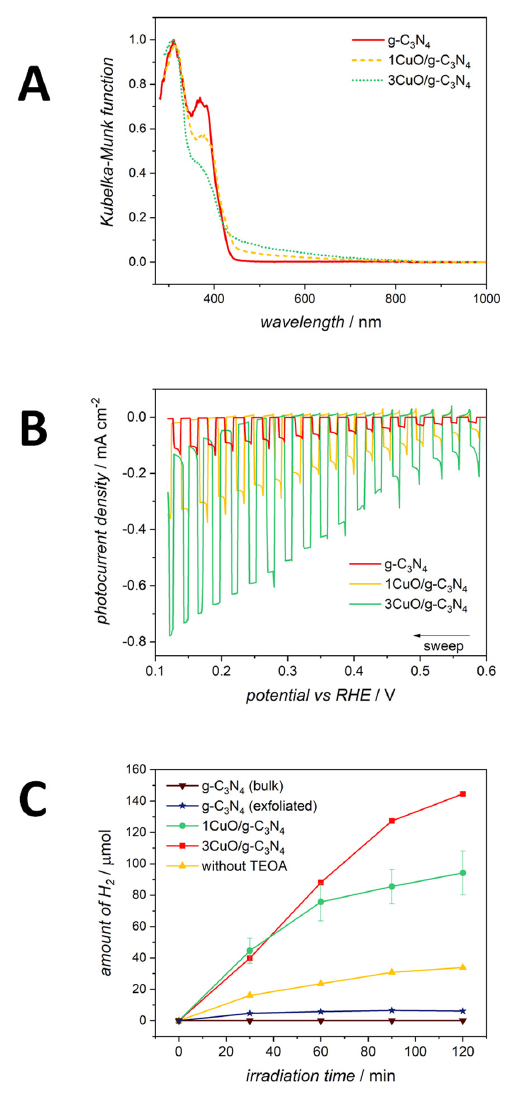
Figure 16. Spectroscopic ( A ) and electrochemical ( B ) study of CuO/g-C 3 N 4 , as well as their photo- catalytic activity towards hydrogen evolution ( C ). Reprinted from [210].